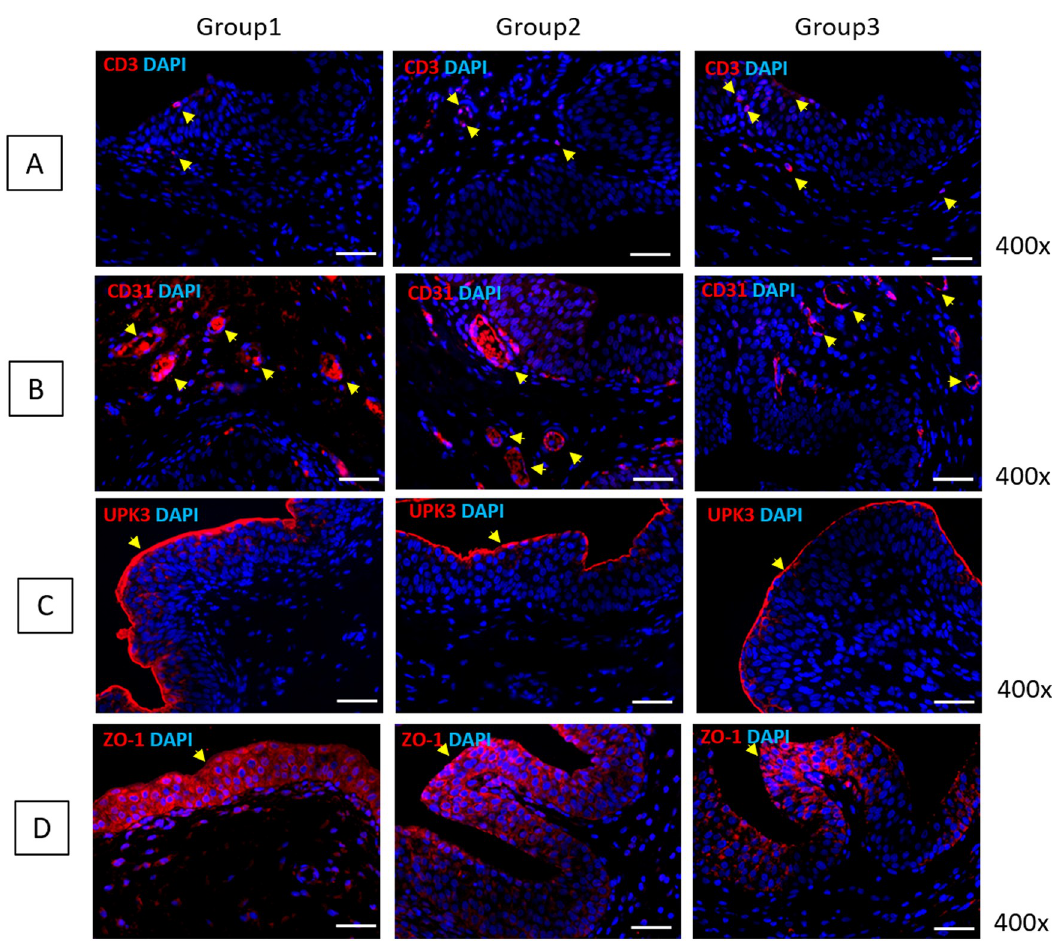
Fig 6. Gene expression results of direct USC injection into the bladder submucosa (Group 1), transurethral instillation of USC (Group 2) and USC injection via the tail vein (Group 3). (A) Group 1 showed significantly reduced CD3-positive cells compared with other groups. (B, C, D) In Group 1, CD31-positive cells were more frequently expressed around blood vessels and the UPK3-positive area was thicker and ZO-1 expression was wider than those in Groups 2 and 3.